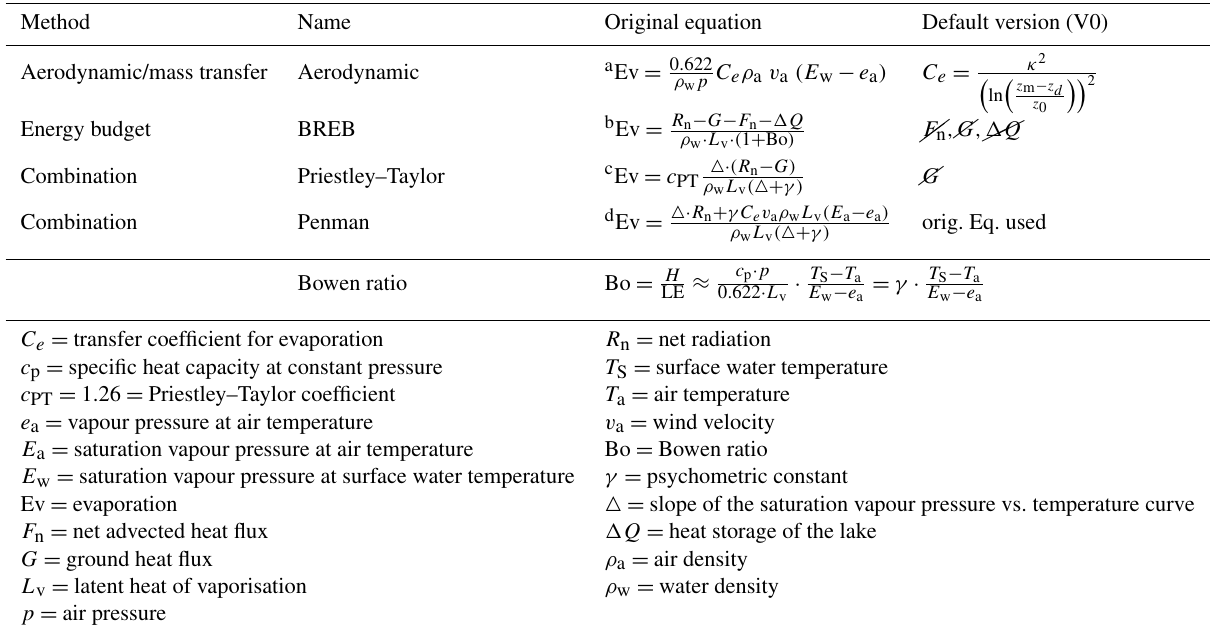
Table 1. Selection of commonly used equations to calculate evaporation (Ev) in mmd − 1 . The original version and the default version (V0) used in Sect. 3.4 and 4.4 are